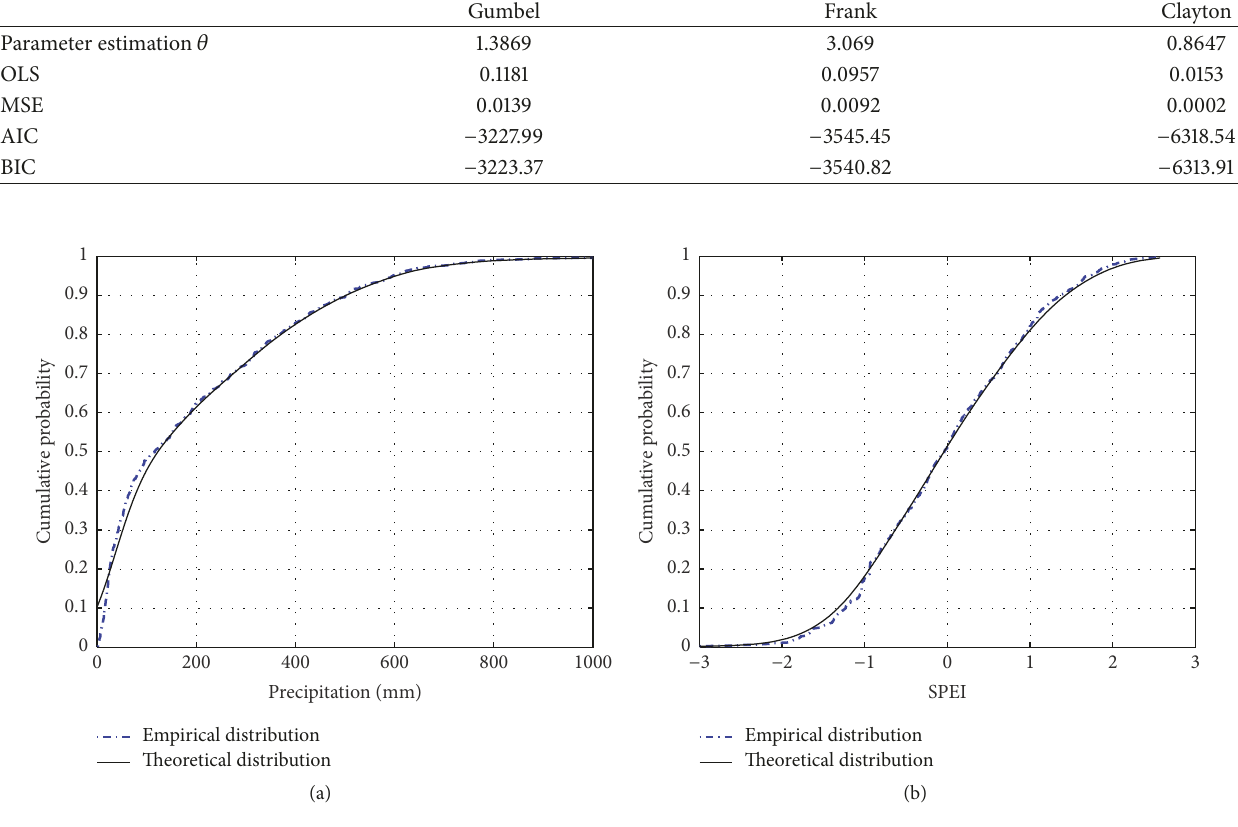
Figure 6: Marginal distributions of (a) precipitation and (b)